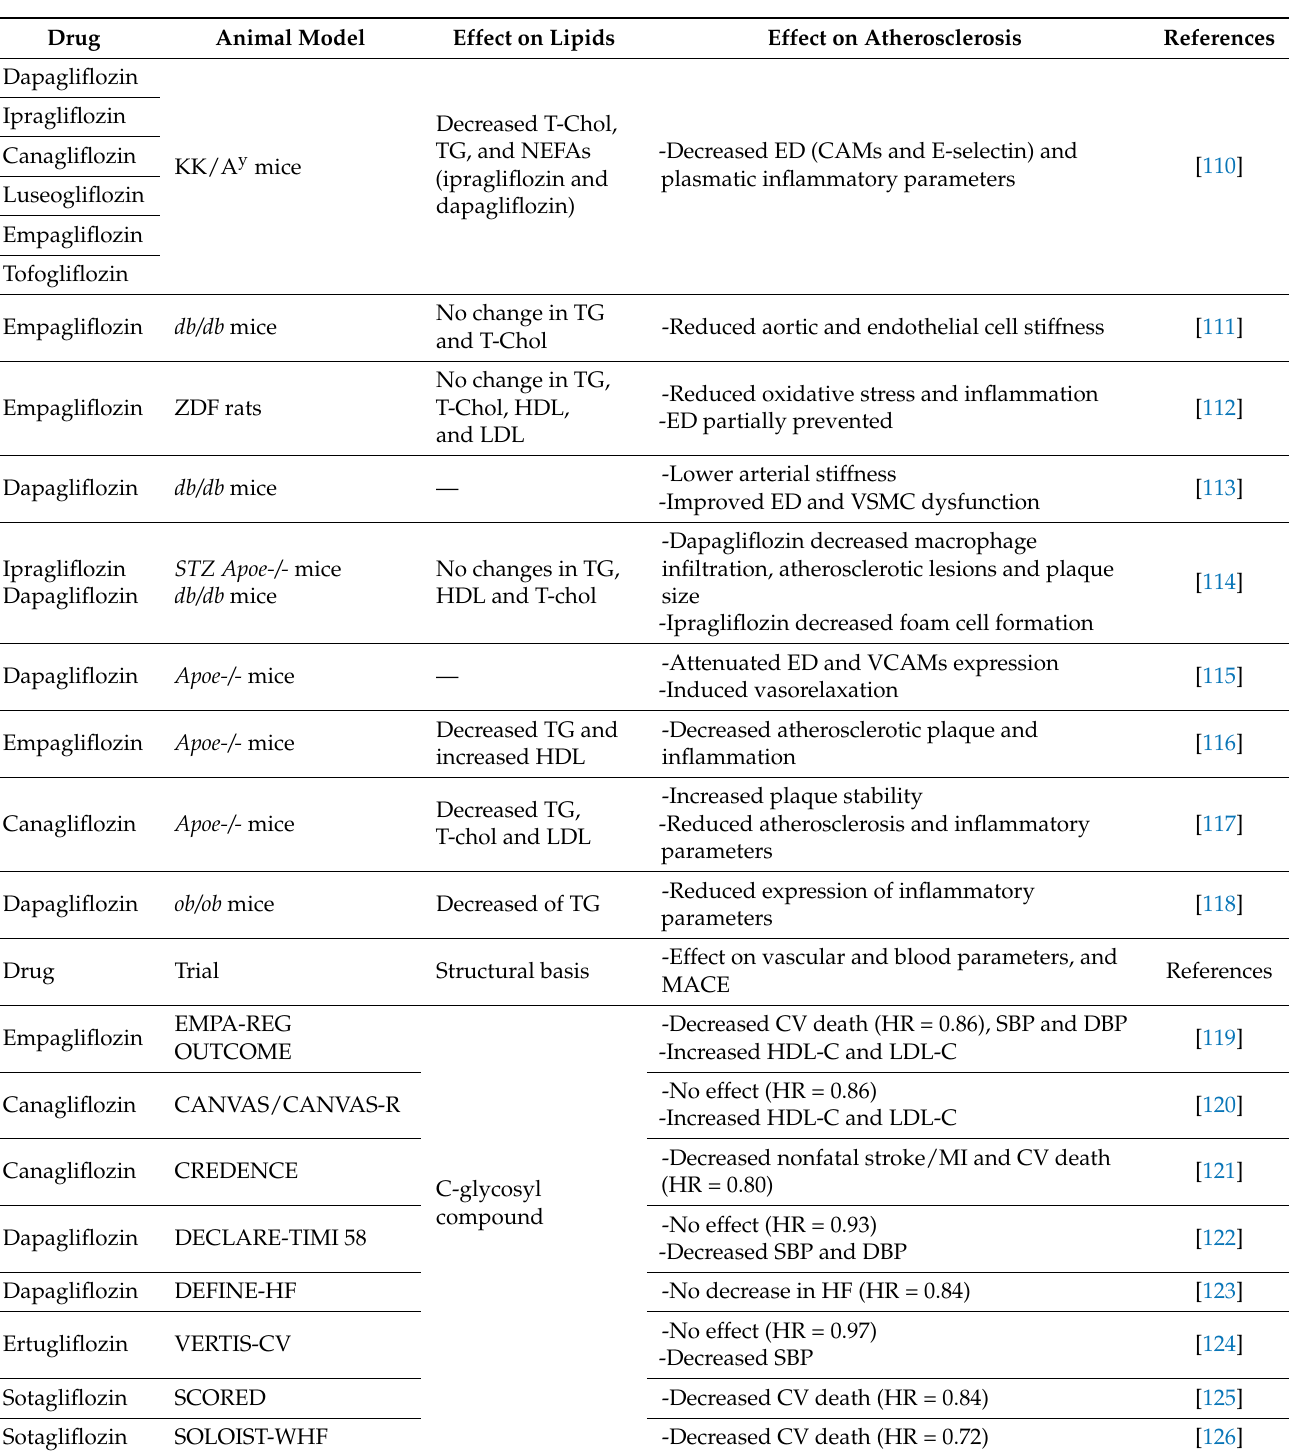
Table 3. Summary of the studies about the effect of SGLT2i in preclinical animal models and in clinical trials of T2DM patients. Drug Animal Model Effect on